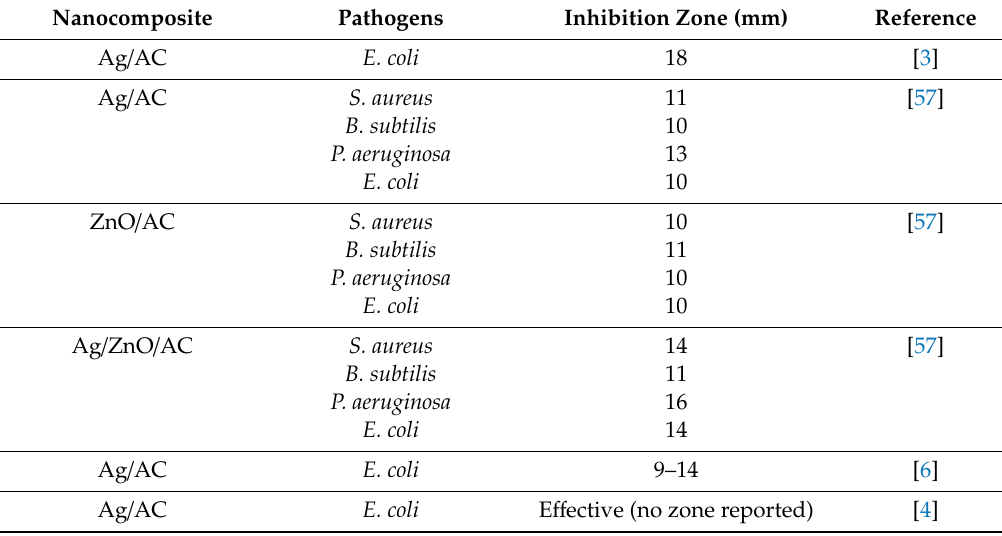
Table 2. List of antibacterial activity of similar samples reported in the literature.